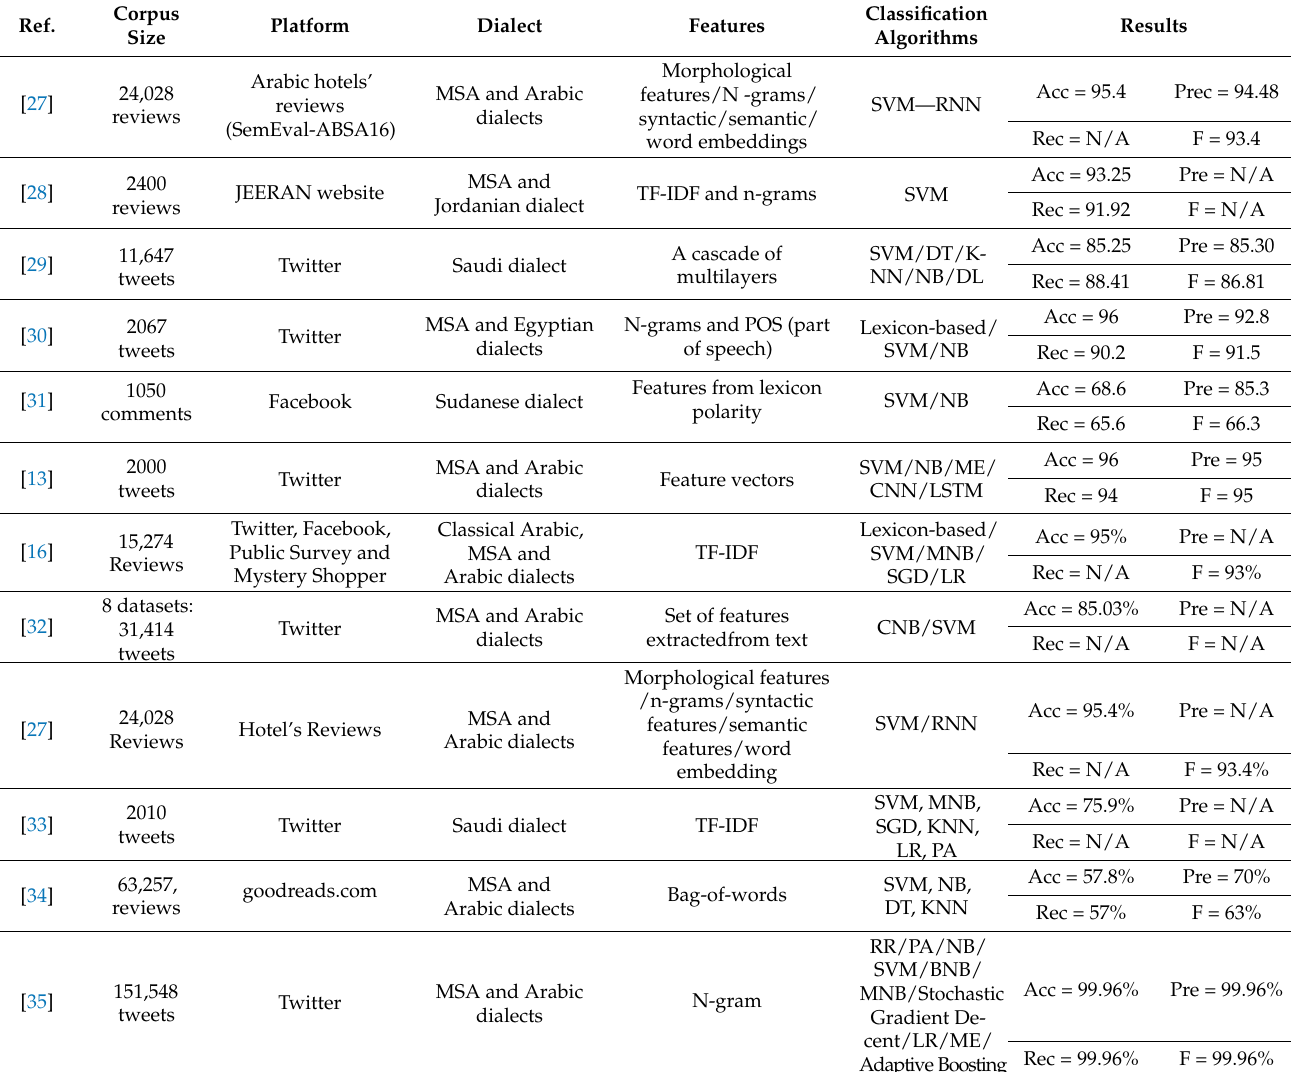
Table 3. Studies and research that involve sentiment analysis for Arabic dialects using machine learning